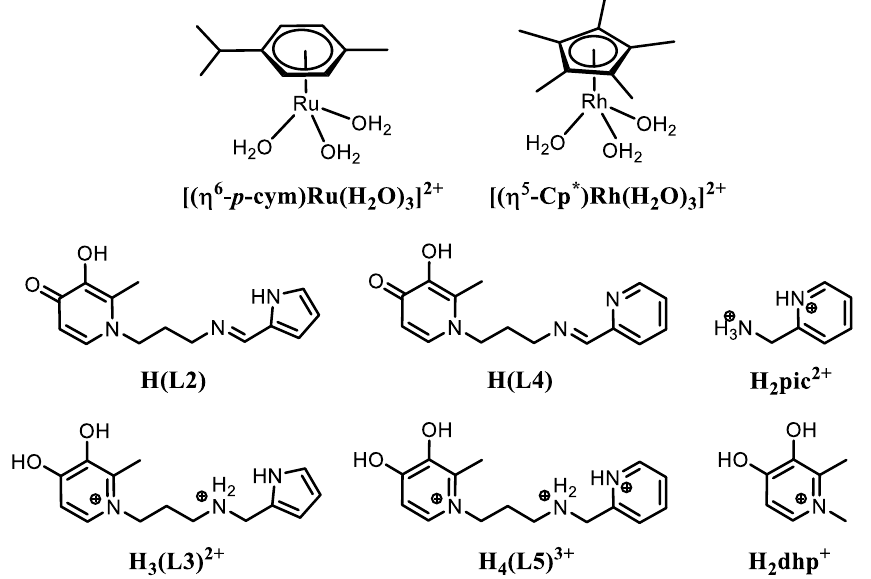
Figure 1. Structure of the studied metal ions, ([( η 6 - p -cym)Ru(H 2 O) 3 ] 2+ and [( η 5 -Cp*)Rh(H 2 O) 3 ] 2+ ), imine ligands, H(L2) and H(L4), as well as the fully protonated forms of their reduced counterparts H 3 (L3) 2+ and H 4 (L5) 3+ together with some model ligands, H 2 pic 2+ and H 2 dhp +